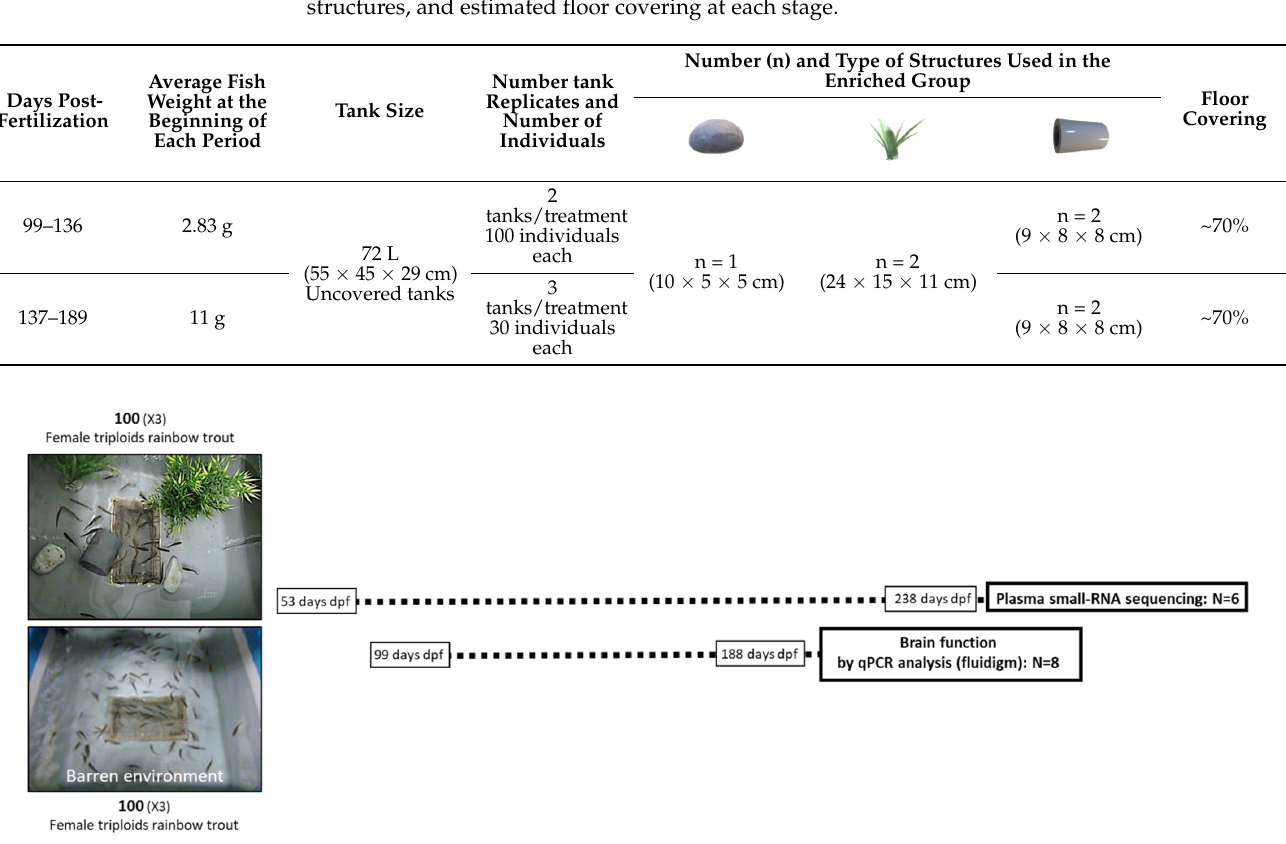
Figure 1. Scheme of experimental procedure.